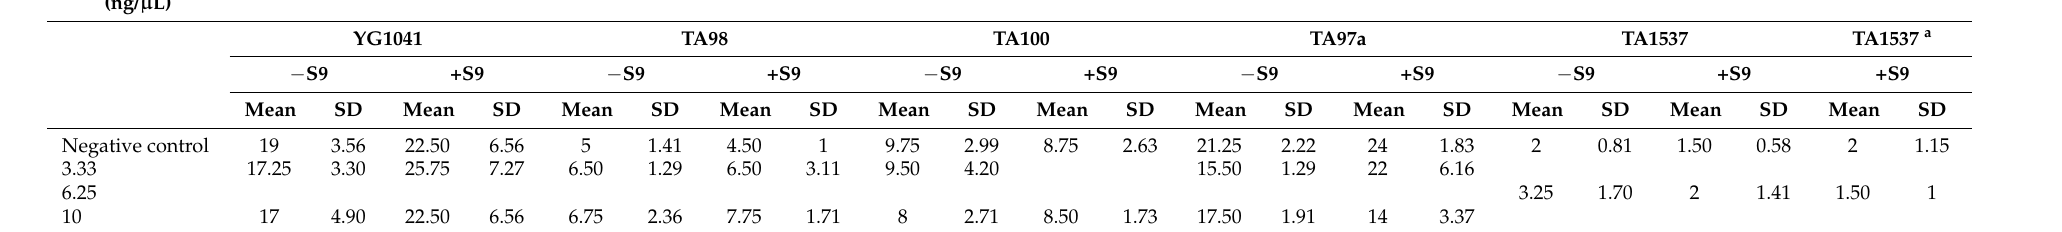
Table 4. Mutagenicity data for dermorubin with YG1041, TA98, TA100, TA97a, and TA1537 strains with and without S9. Concentration Mean of Number of Revertants/Well and Standard Deviation (ng/ µ L)